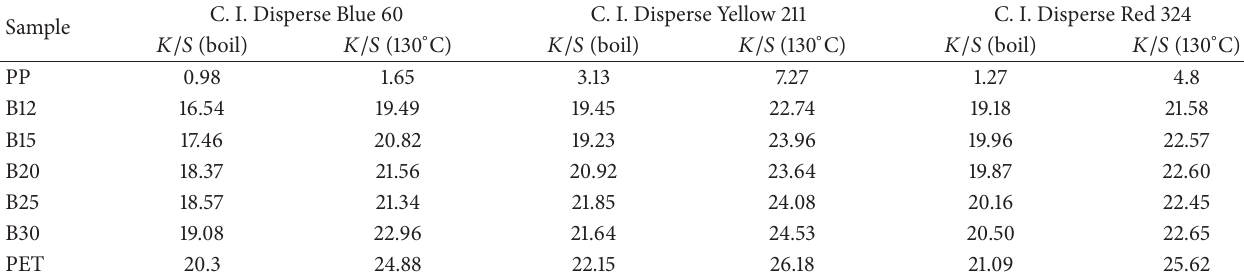
Table 4: The 𝐾/𝑆 values of dyed pure and blend fibers with three disperse dyes at boil and 130 ∘ C. Sample